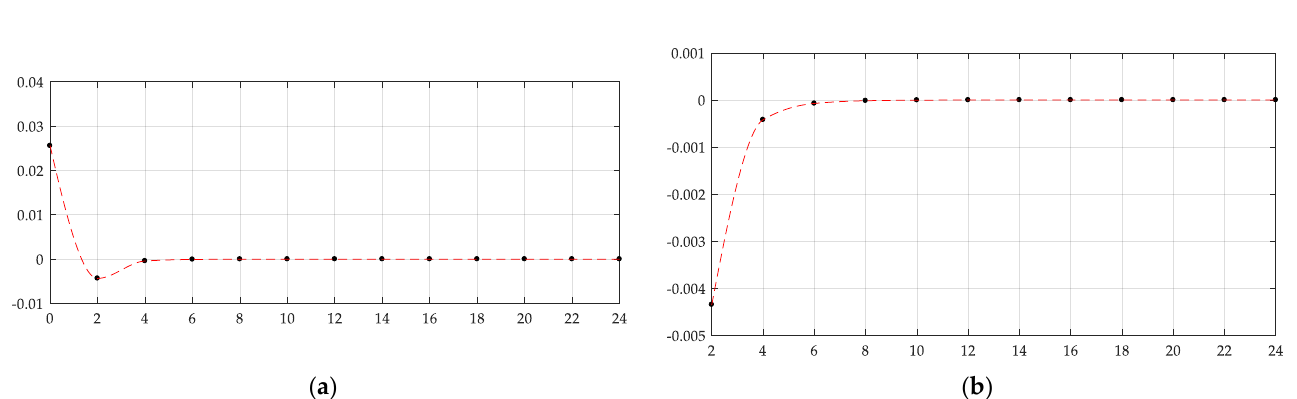
Figure 6. Variation of